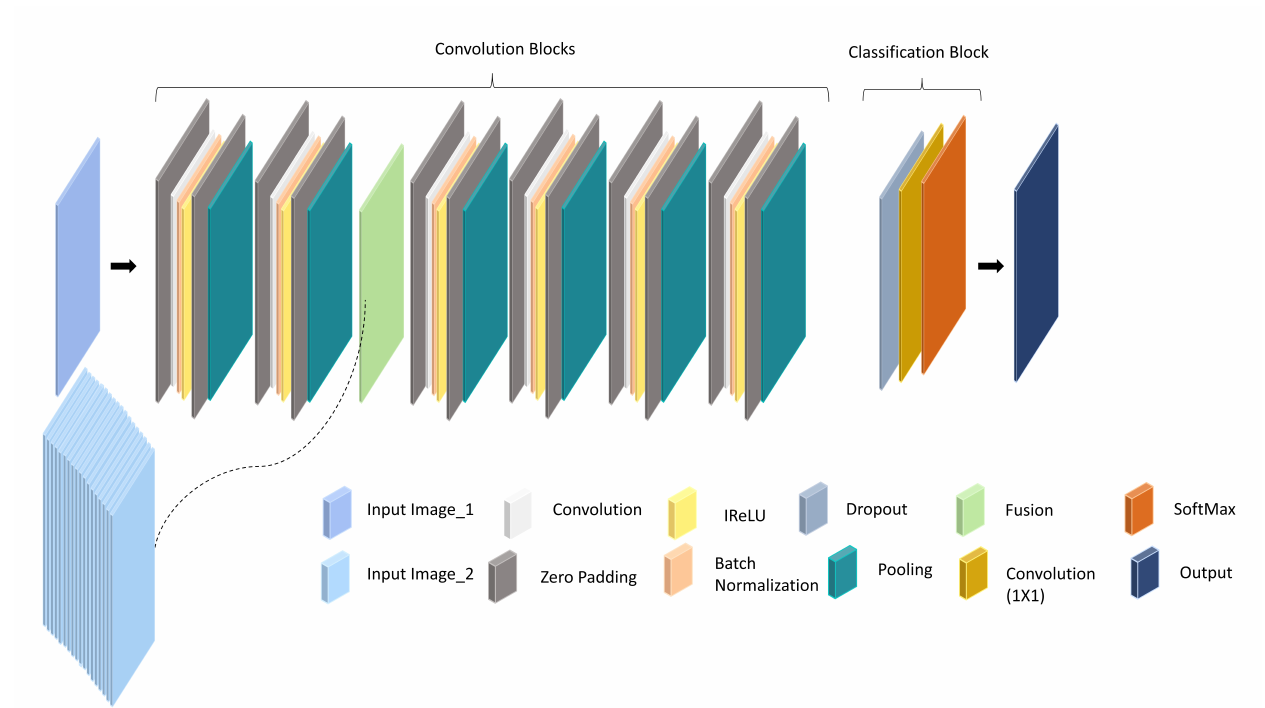
Figure 9. Suggested network architecture of Modified FCN-DK6_2 for combining RSI and SVI feature map at 2nd convolution block (RSI is Input–Image_1 and stacked feature map of SVI is